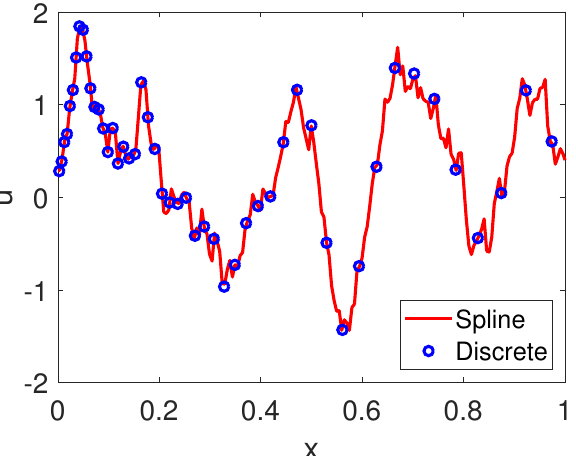
Figure 2. Spline through digital filter based pseudo turbulence and corresponding values interpolated on the computational